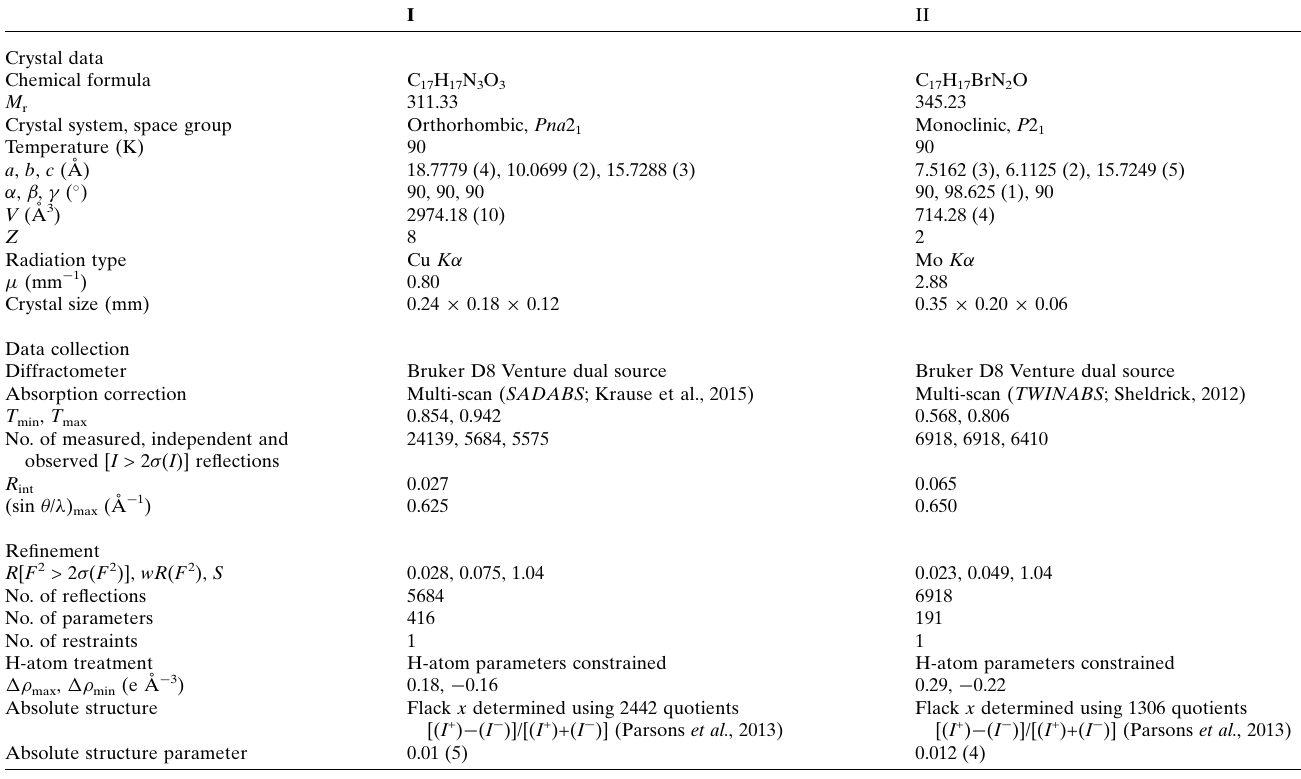
Table 2 Experimental details.